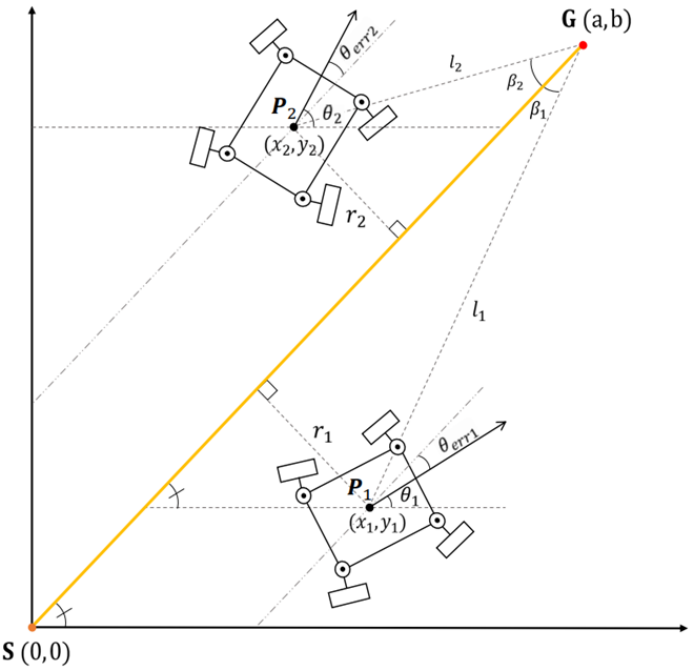
Figure 12. A view of the rover projected on a 2D Cartesian coordinate system as observed from the Moon’s orbit.